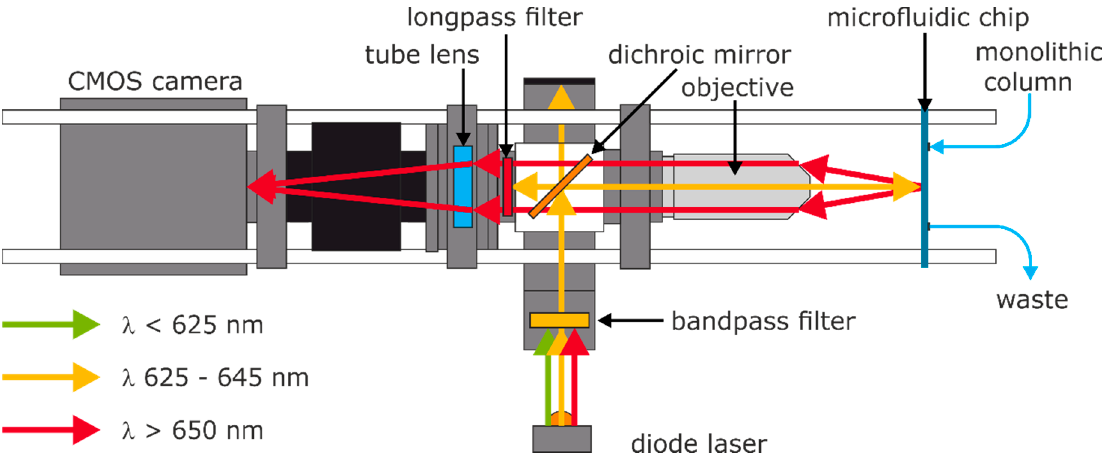
Figure 2. Light paths in the setup with essential optical components.